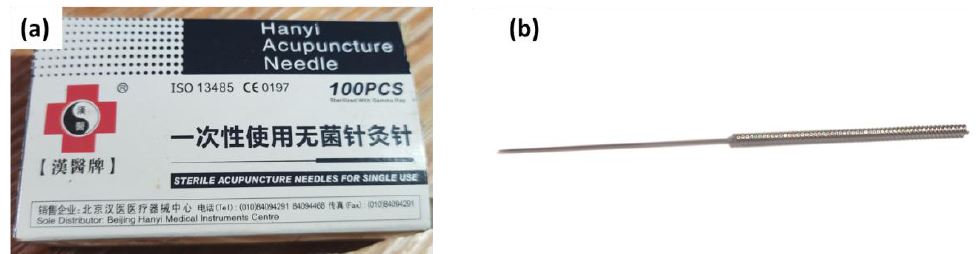
Figure 2. The images of (a) stainless-steel substrates by and (b) stainless-steel